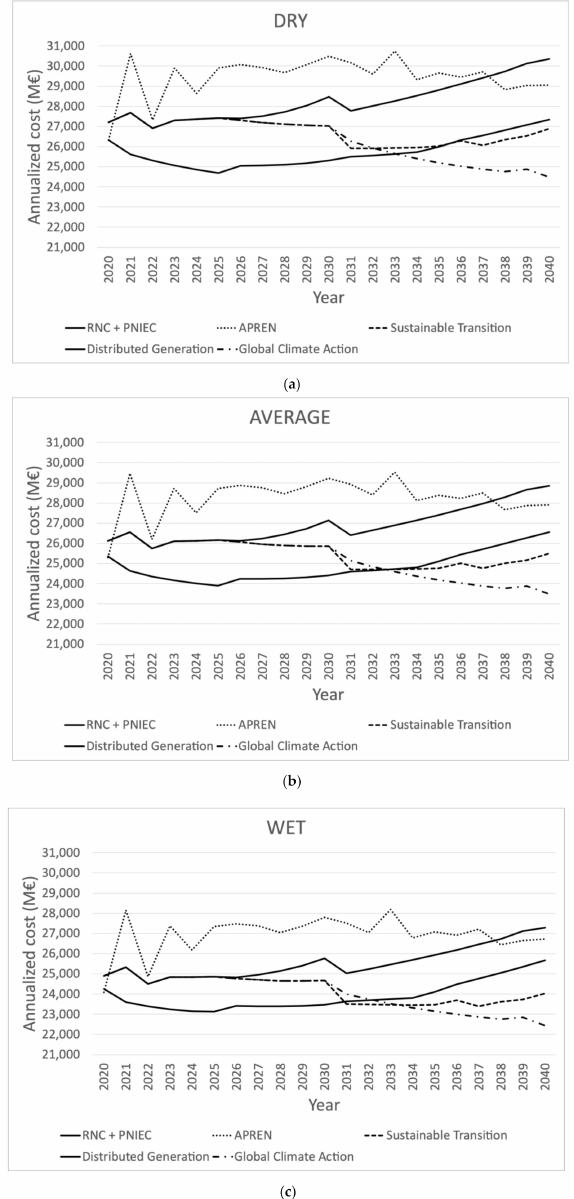
Figure 6. Generating technologies annualized cost for different hydro profiles: ( a ) hydro dry profile; ( b ) hydro average profile; ( c ) hydro wet